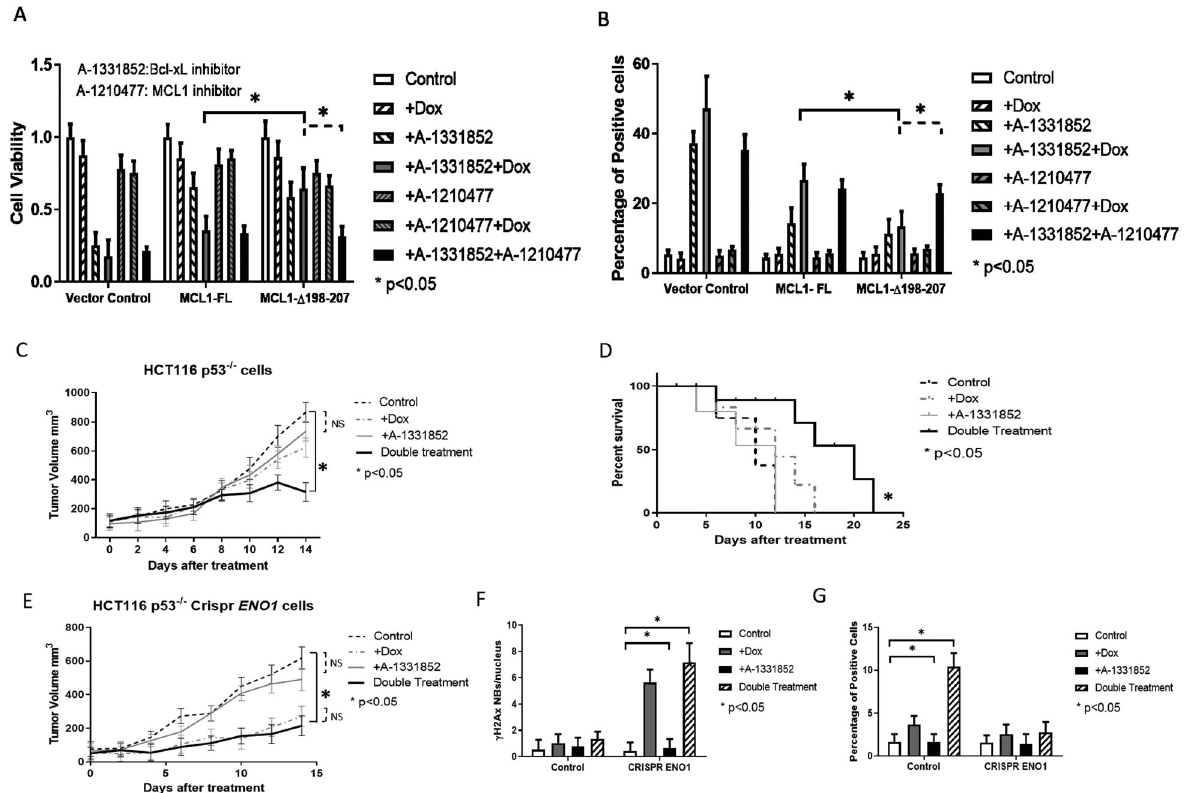
Fig. 6 Nuclear translocation of MCL1 proteins affect its apoptosis activity in vitro and in vivo. A . Quantitative analysis of cell viability test in HCT116 p53 − / − with CRISPR MCL1 cells treated with doxorubicin (100 ng/ml), Bcl-xL inhibitor A-1331852 (1uM), MCL1 inhibitor A-1210477 (10uM), or combined treatments for the indicated HCT116 p53 − / − with CRISPR MCL1 cells expressing wild type or mutant MCL1 . The solid line indicates the comparison of cells expressing full length or mutant MCL1 treated with Bcl-xL inhibitor A-1331852 with doxorubicin. The dotted line indicates the comparison of cells expressing mutant MCL1 treated with Bcl-xL inhibitor A-1331852 with doxorubicin or MCL1 inhibitor. T-test is used to calculate the p- value. *, p < 0.05. Error bars represent + / − S.D. B Quantitative analysis of cleaved caspase 3 staining in HCT116 p53 − / − with CRISPR MCL1 cells expressing WT or mutant MCL1 . Cells were treated with doxorubicin, Bcl-xL inhibitor A-1331852, MCL1 inhibitor A-1210477, or combined treatments. T-test is used to calculate the p -value, *, p < 0.05. Error bars represent + / − S.D. The solid line and dotted line are explained above. C tumor growth curves of HCT116 p53 − / − xenografts. Mice ( N = 5 for each group) were injected with HCT116 p53 − / − cells. Mice received either doxorubicin (1.2 mg/kg i.p. q3d) or A-1331852 (25 mg/kg PO via oral gavage q1d), no drug treatment group were used as control. Error bars represent + / − S.D. T-test is used to calculate the p -value. *, p < 0.05 for tumor growth in the double treatment group, comparing with no drug treatment control group. N.S. indicate no signi fi cance according to p- value. D . mice ( N = 5 for each group) survival data, with injected with doxorubicin and/or A-1331852 as indicated above. T-test is used to calculate the p value and *, p < 0.05 for the indicated doxorubicin and double treatment treated tumors (black solid line) comparing with no drug treatment controls (black dash line). N. S. indicate no signi fi cance according to p -value. Mice death is calculated as either mice that died during treatment or when tumor size reached 15 mm in diameter. E Tumor growth curves of xenograft HCT116 p53 − / − cells with CRISPR ENO1 . Mice ( N = 5 for each group)